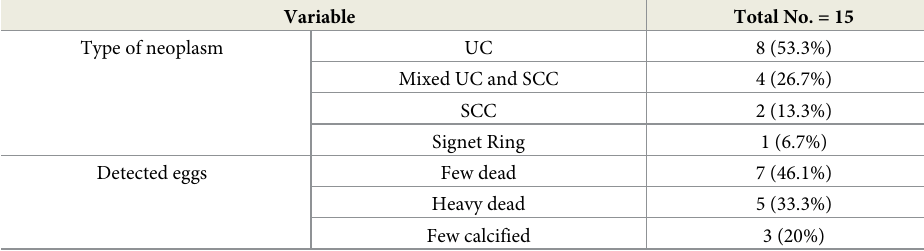
Table 2. Pathological data of the studied